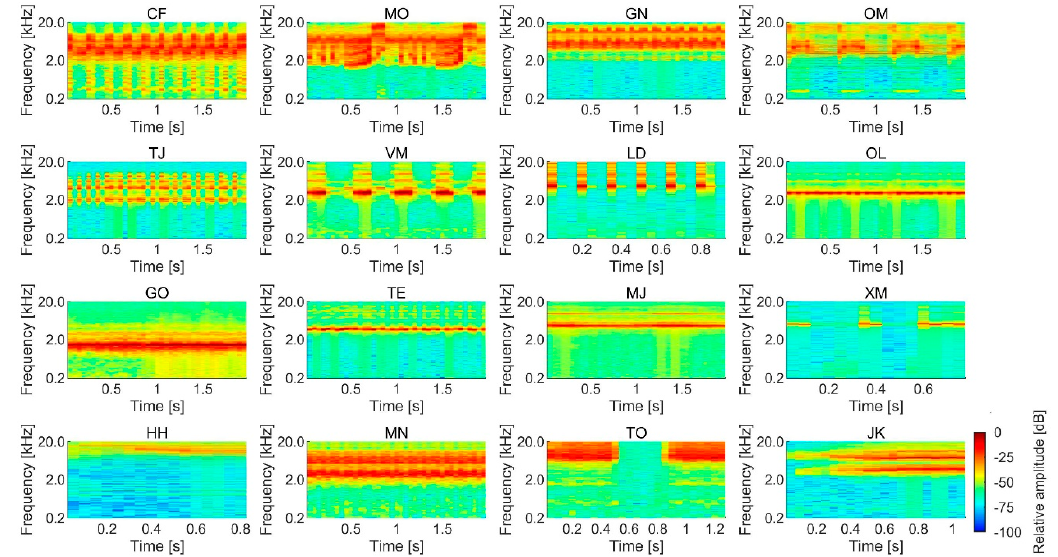
Figure 4. Spectrograms of the 16 insect song stimuli used.